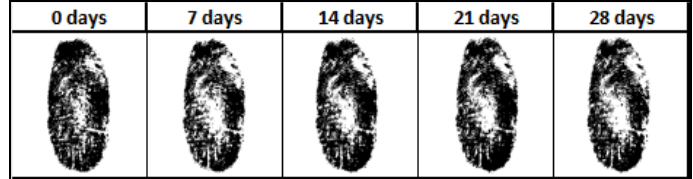
Figure 5. Visible ridge detail for blood-stained fingerprints with hyperspectral imaging (HSI) on day 0, 7, 14, 21, and 28.